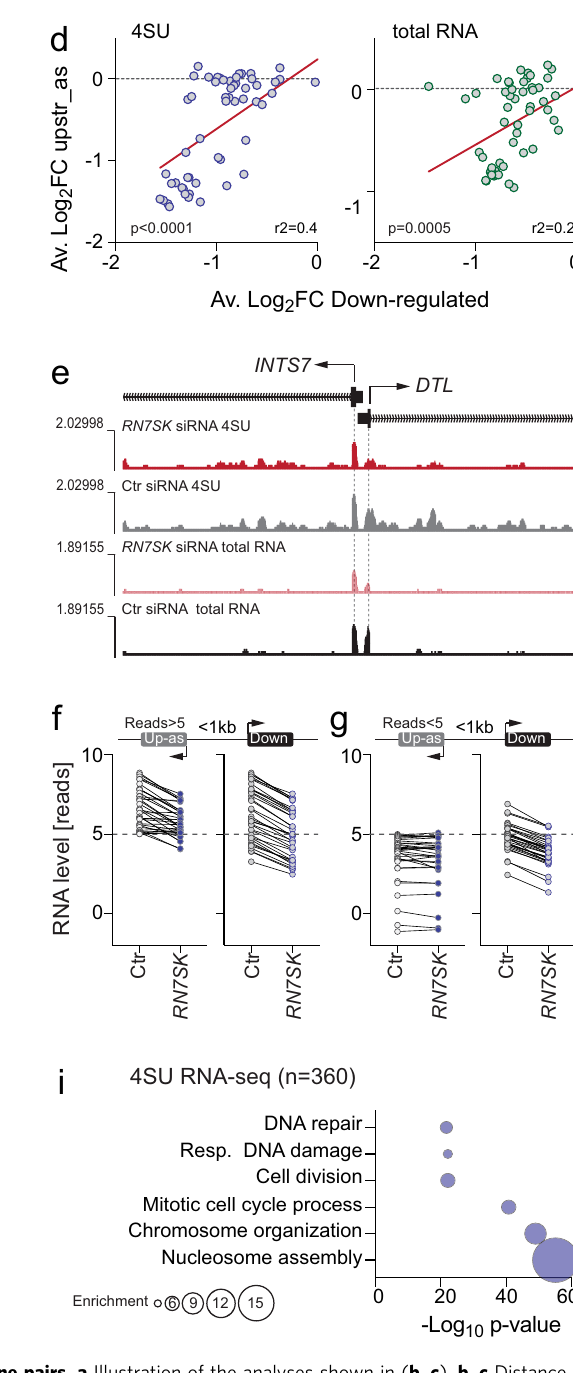
Fig. 4 7SK orchestrates bi-directional transcription of highly expressed gene pairs. a Illustration of the analyses shown in ( b , c ). b , c Distance (upper panels) and frequency (lower panels) of genes with upstream ( b ) or downstream ( c ) antisense (as) (left panels) or sense (ss) (right panels) genes within 1000 bases (1 kb) distance (grey dotted box). Up- (orange) and down- (blue) regulated genes were de fi ned based on two independent 4SU and total RNA- seq datasets. All (grey) = all protein-coding genes; Up = genes with log 2 FC > 0.3 and padj < 0.05; Down = genes with log2FC < − 0.3 and padj < 0.05 (Wald test with FDR correction). The Up and Down groups were compared to all protein-coding genes. Violin plots show the median and interquartile range and width indicating frequency ( b , c upper panels). P -value calculation (see “ Methods ” ). d Correlation of RNA levels of downregulated genes with their upstream as genes shown as average log 2 fold-changes (FC) in two independent 4SU (left panel) and total RNA (right panel) sequencing datasets. P -value tests slope deviation from 0. e – g UCSC genome browser shots of bi-directional repressed DTL and its upstream anti-sense gene partner INTS7 (e) . RNA levels (reads) of new transcripts of downregulated genes (padj < 0.05; FC < − 0.5; n = 485) with bi-directional as gene less than 1 kb away and more than an average of 5 reads ( n = 36 genes) ( f ) or less than 5 reads ( n = 33 genes) ( g ) in upstream antisense (dark blue) or downstream sense (light blue) directions in control (ctr) siRNA transduced cells. h Reactome of all bi-directionally orientated gene pairs less than 1 kb apart. i Gene ontology analyses using all common signi fi cantly (padj < 0.5; Wald test with FDR correction) downregulated genes in the 4SU RNA seq datasets. Background: all expressed genes. Source data are provided as a Source Data fi